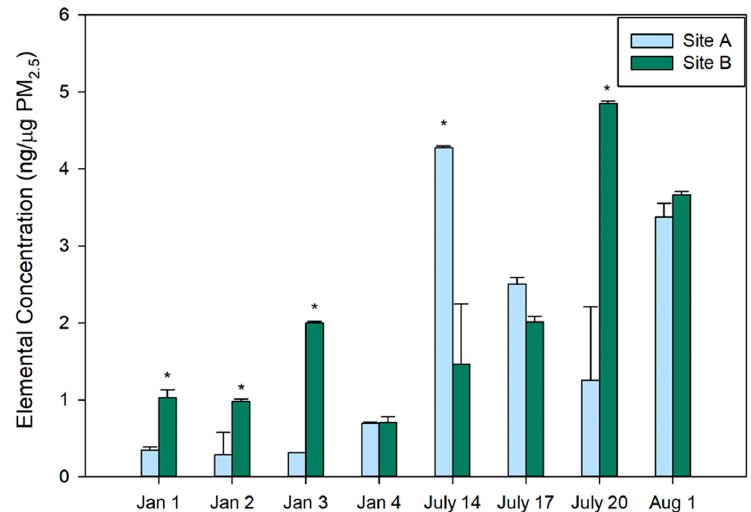
Figure 1. Total elements/PM 2.5 mass (ng/µg) for Site A and B in winter and summer. Elements (ng) per PM 2.5 mass (µg) for each sampling day for Sites A and B are reported for January (Jan.) and July. Element concentrations represent the summed totals of all elements that were quantified for a given sample following blank correction. The legend represents Site A and Site B with their corresponding colors. Mean concentrations with standard deviation, represented by error bars, are reported based on triplicate measurements. A two-way ANOVA was used to determine significant differences ( p ≤ 0.05) between the sampling sites and days denoted by *. Atmosphere 2020 , 11 , x FOR PEER REVIEW